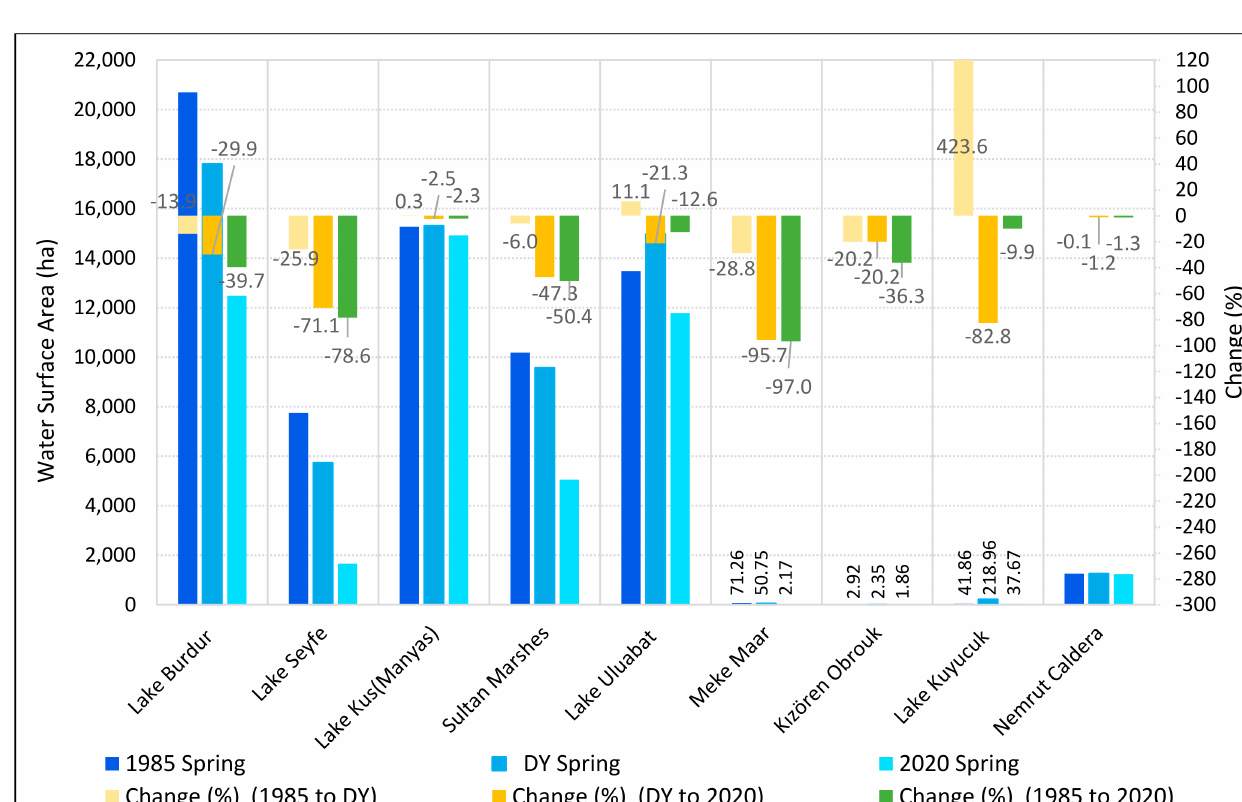
Figure 3. Water surface areas and changes from 1985 to DY and DY to 2020 (%) in the inland Ramsar sites in